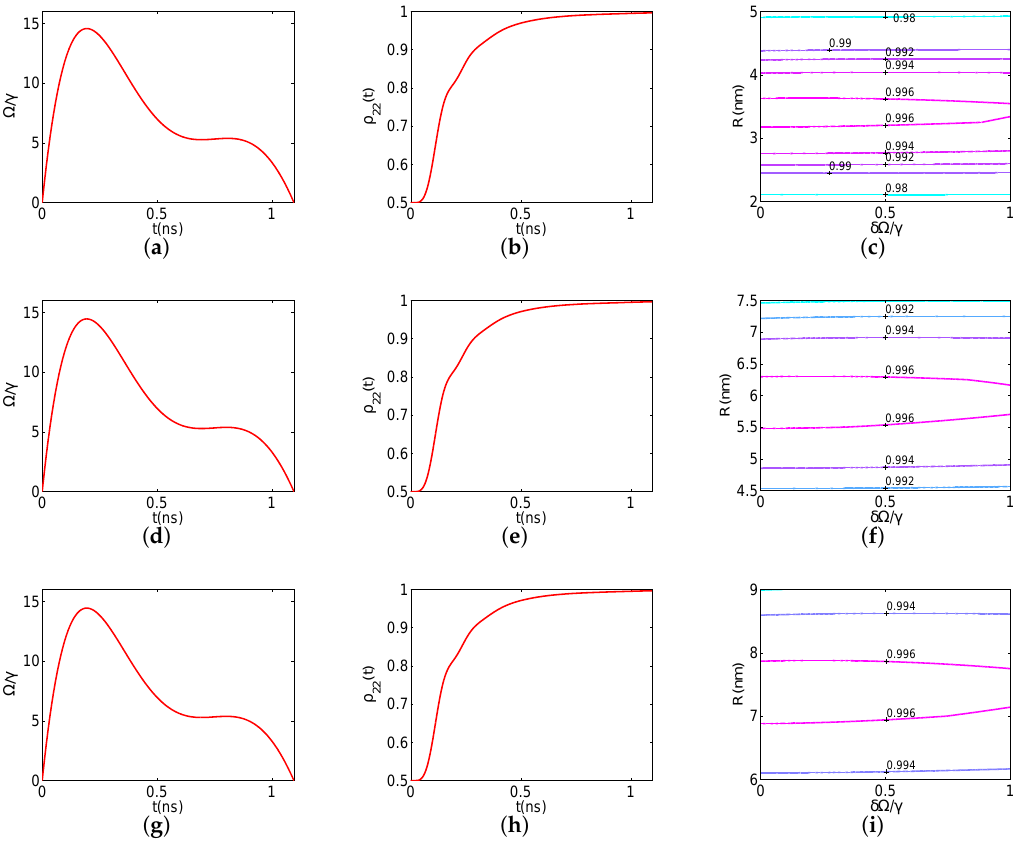
Figure 6. Three examples with optimized time-dependent control for duration T = 2/ γ = 1.097 ns: good quality MoS 2 layer at R = 3.5 nm (first row), medium quality MoS 2 layer at R = 6 nm (second row), and bad quality MoS 2 layer at R = 7.5 nm (third row). ( a , d , g ) Optimal control Ω ( t ) . ( b , e , h ) Corresponding ρ 22 ( t ) . The final value ρ 22 ( T ) = 0.9963 exceeds the value 0.9945 achieved with constant Rabi frequency in the second column of Figure 3. ( c , f , i ) Sensitivity diagram of ρ 22 ( T ) achieved with the optimal profile Ω ( t ) , for a positioning error around the nominal value R = 3.5,6,7.5 nm and a constant error δ Ω in the